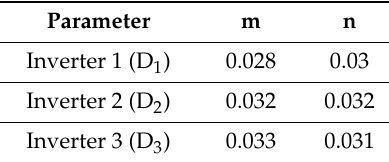
Table 3. Selected droop gains.